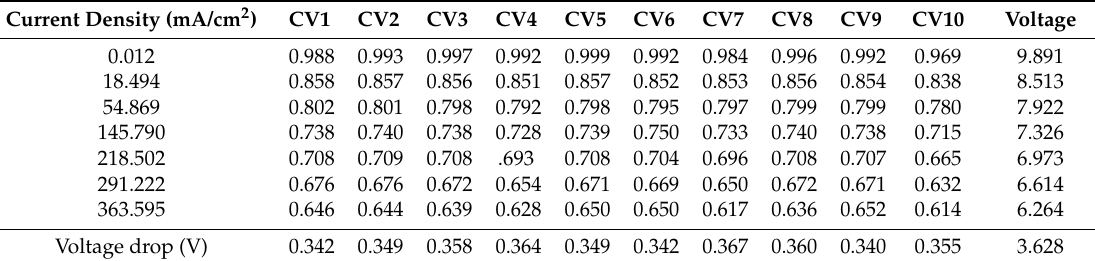
Table 3. Dynamic performance at different relative humidities (55%).